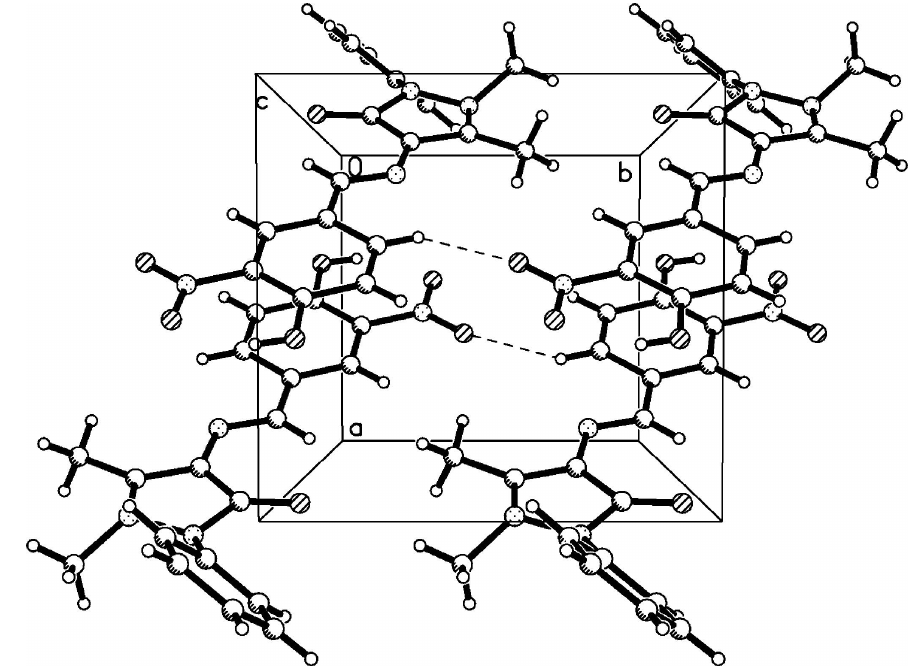
Figure 2 The packing of (I), with C—H···O hydrogen bonds indicated by dotted lines. ( E )-4-(4-Hydroxy-3-nitrobenzylideneamino)-1,5-dimethyl-2-phenyl-1 H -pyrazol-3(2 H